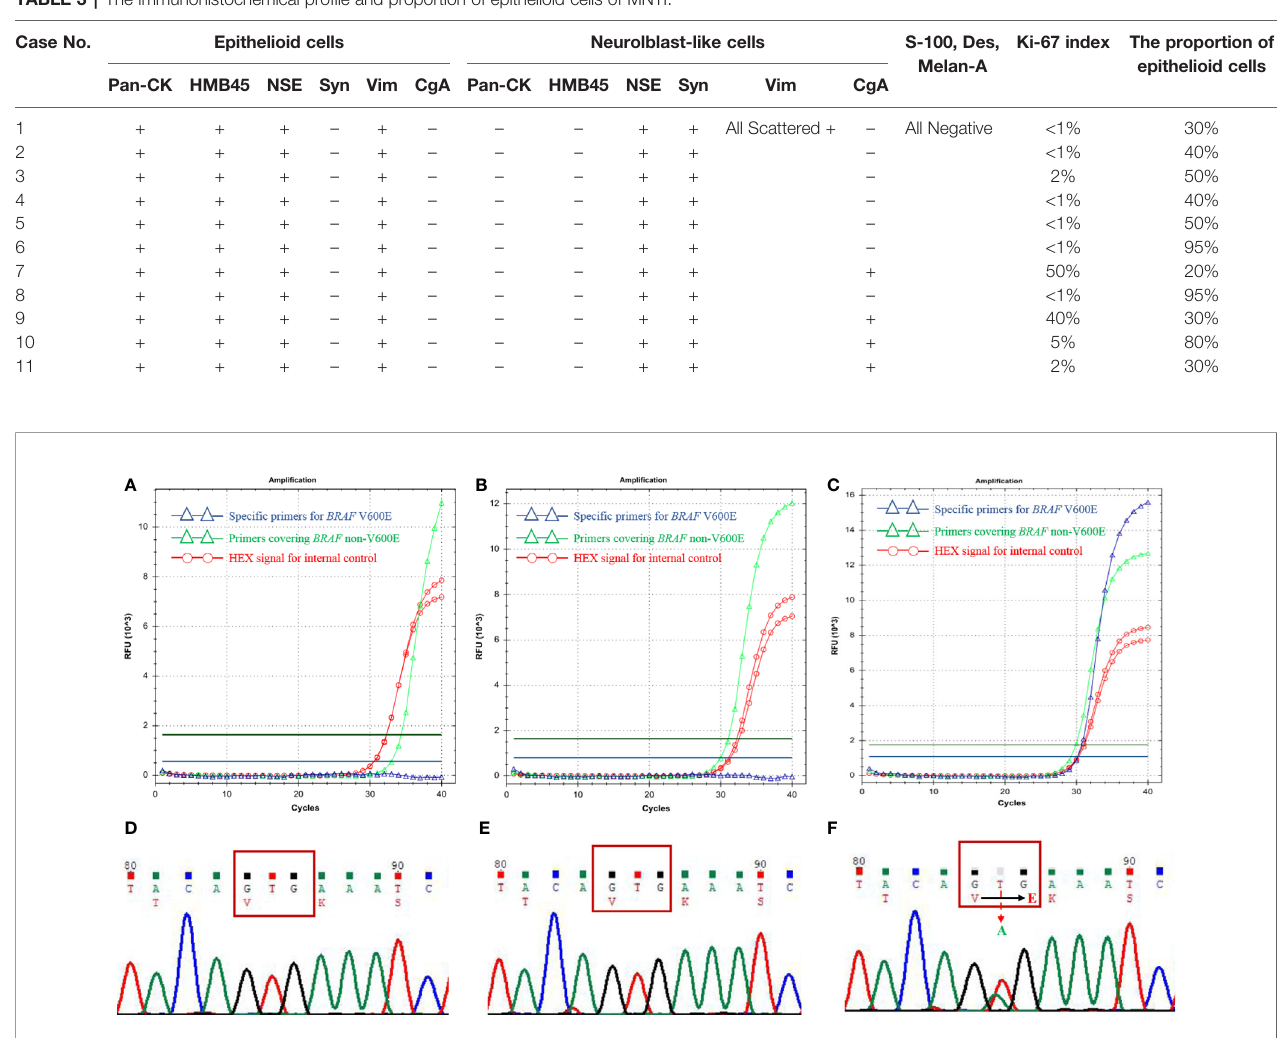
FIGURE 4 | BRAF V600E mutation detections in MNTIs and LCH. Detections performed by ARMS-qPCR and Sanger Sequencing showed Case 1 (A, D) and Case 11 (B, E) were negative for BRAF V600E mutation, while the positive control, LCH case was positive for BRAF V600E mutation (C, F) .